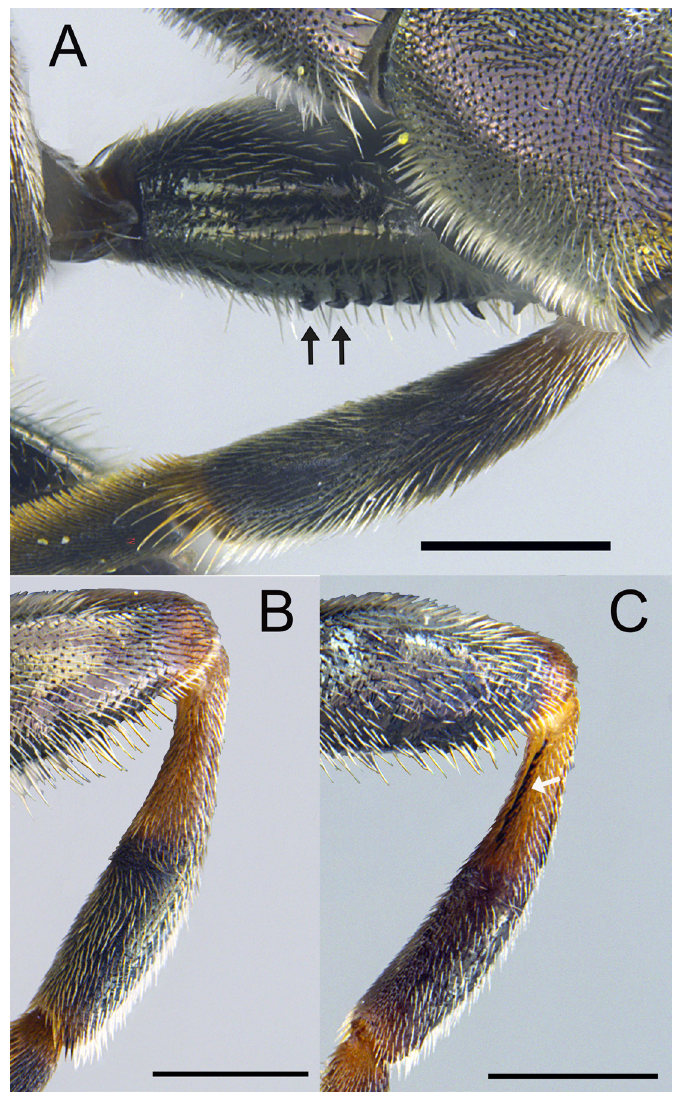
Fig. 5. Metalegs of species of Eumerus Meigen, 1822. A–B . Eumerus colladoi Ricarte & Aguado- Aranda sp. nov., holotype, ♂ (CEUA-CIBIO). C . Eumerus amoenus Loew, 1848, ♂ (CEUA-CIBIO). Scale bars: